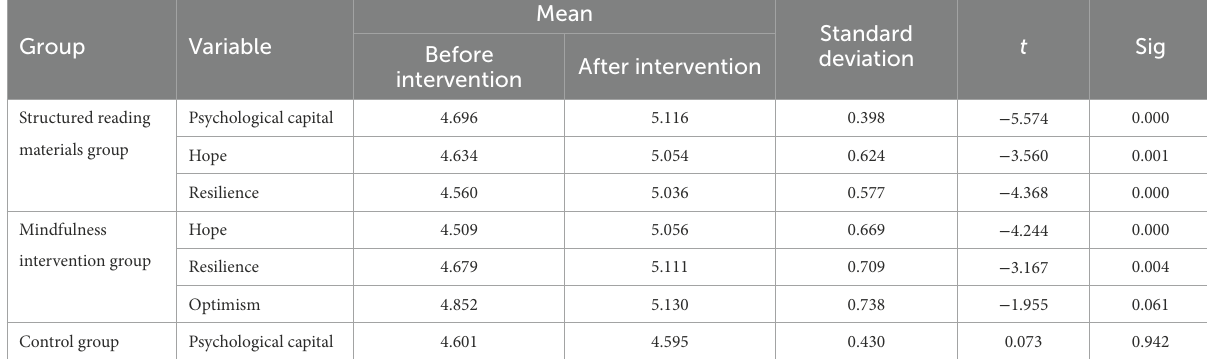
TABLE 3 Matched sample t -test.